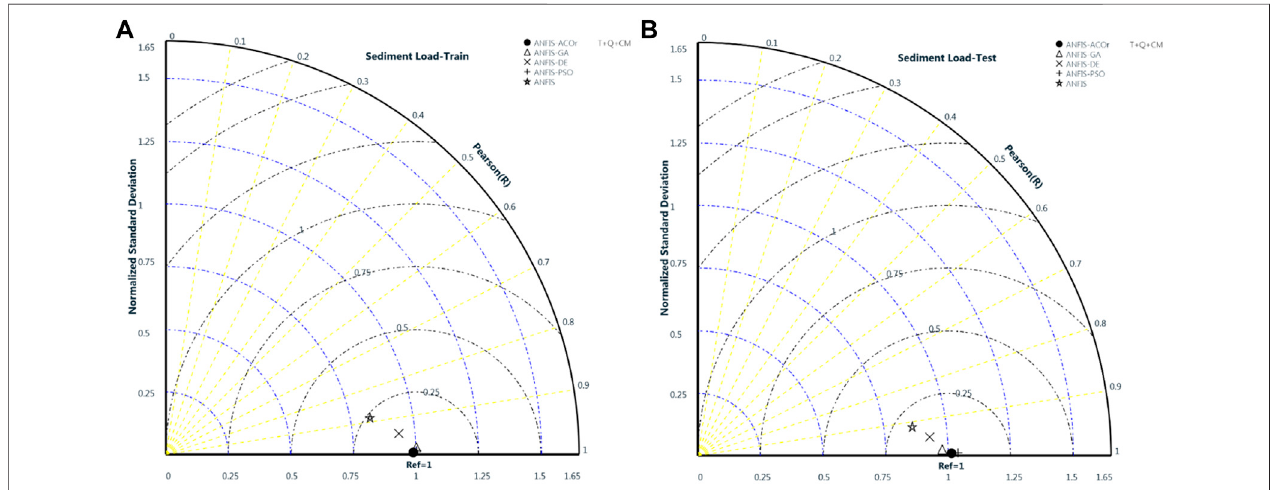
bold values are the highest achieved values for each algorithms.